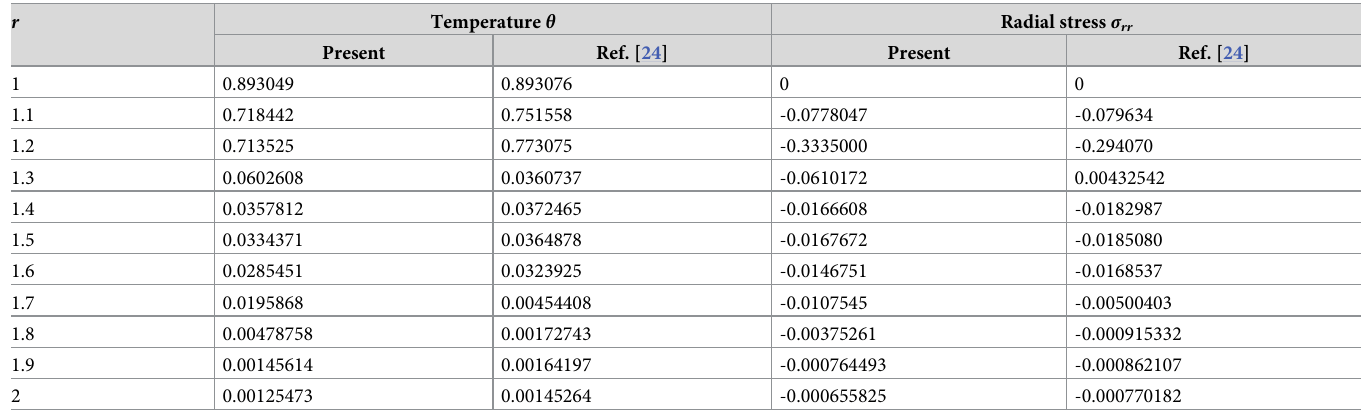
Table 1. Comparison of the distribution temperature θ and radial stress σ rr with Ref.